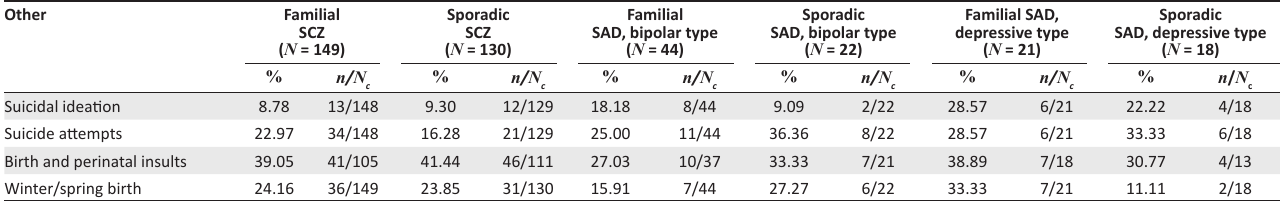
TABLE 1h: Demographic & clinical characteristics of 214 familial and 170 sporadic participants with a DSM diagnosis of schizophrenia or schizoaffective disorder.